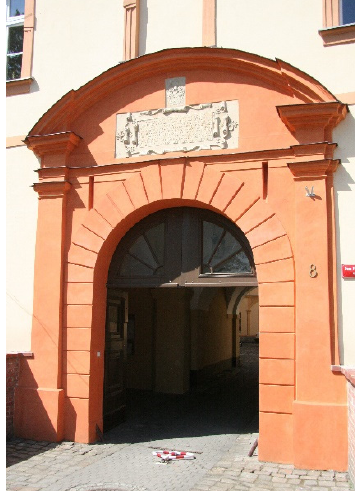
figural sgraffito d é cor on the west bastion elevations (Königer 1938, p. 65).